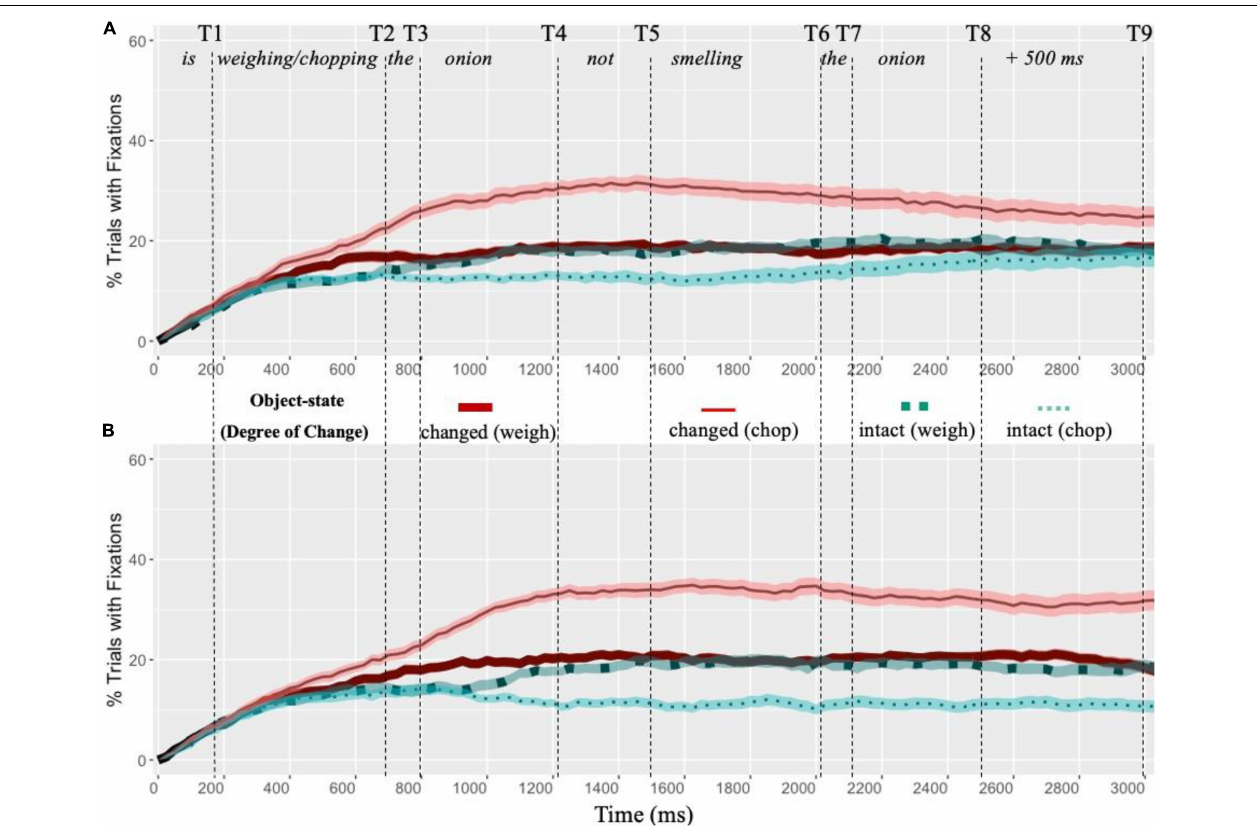
FIGURE 2 | Percentage of trials with fixations launched on the interest areas (AOIs) across sentential conditions. (A) Fixations of native speakers. (B) Fixations of non-native speakers. The x -axis shows the elapsed time increments from the onset of linguistic stimuli (e.g., “ The rabbit is weighing/chopping the onion, not smelling the onion ”). The y -axis shows percentage of trials with at least one fixation on the AOIs. Standard errors above and below the mean were shown as shaded areas. The dashed lines indicate the offset of critical time